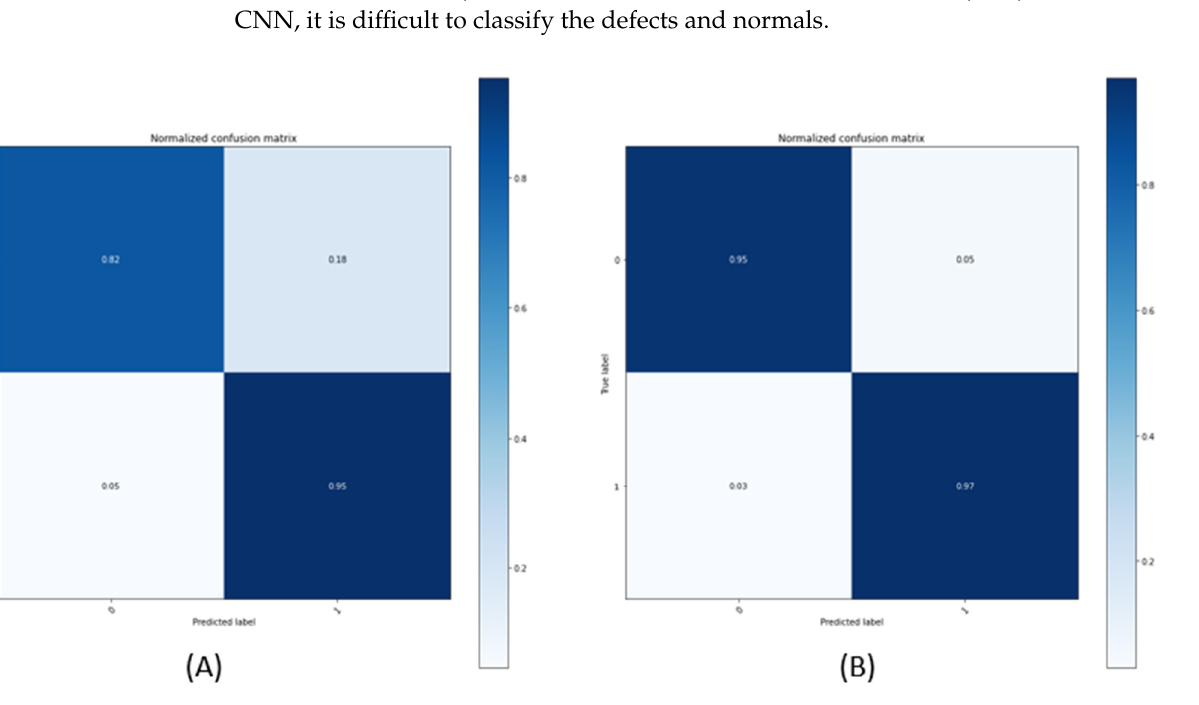
Figure 9. Confusion metrics of the student model CNN and AE: ( A ) CNN; ( B ) AE.